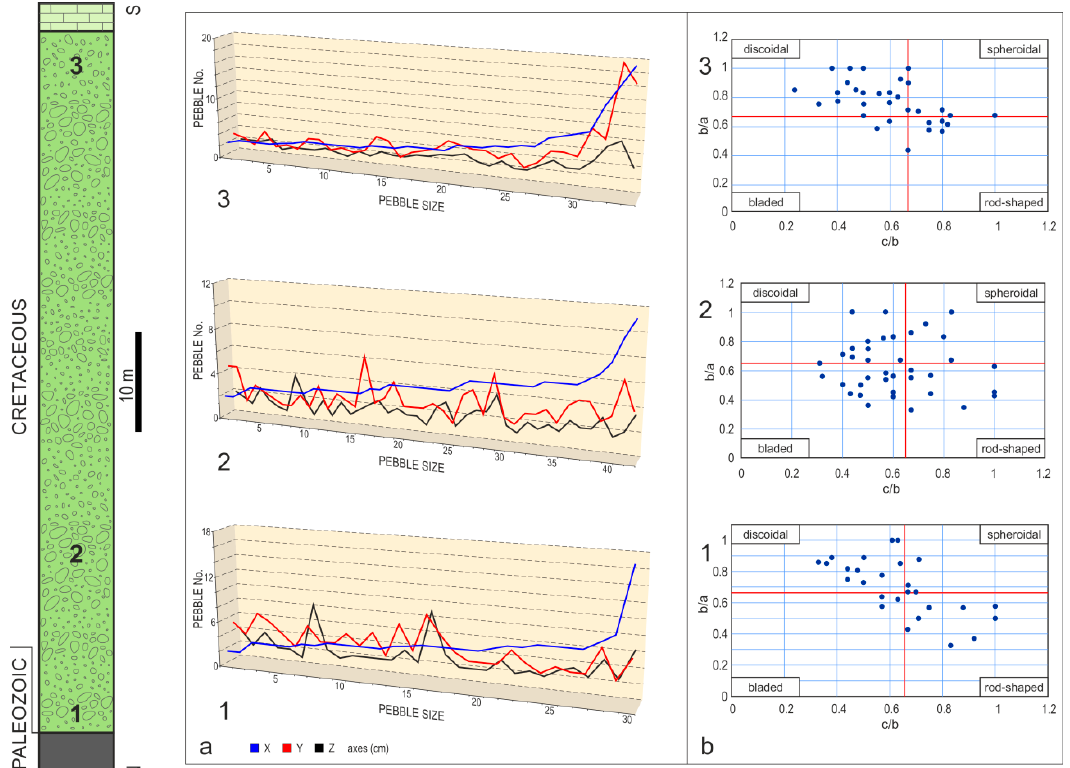
Figure 7. Distribution of clast size across x, y and z axes at Statistics Points 1, 2 and 3. Shape of clasts presented according to Zingg [33]. Position of sampling points shown on a schematic column.